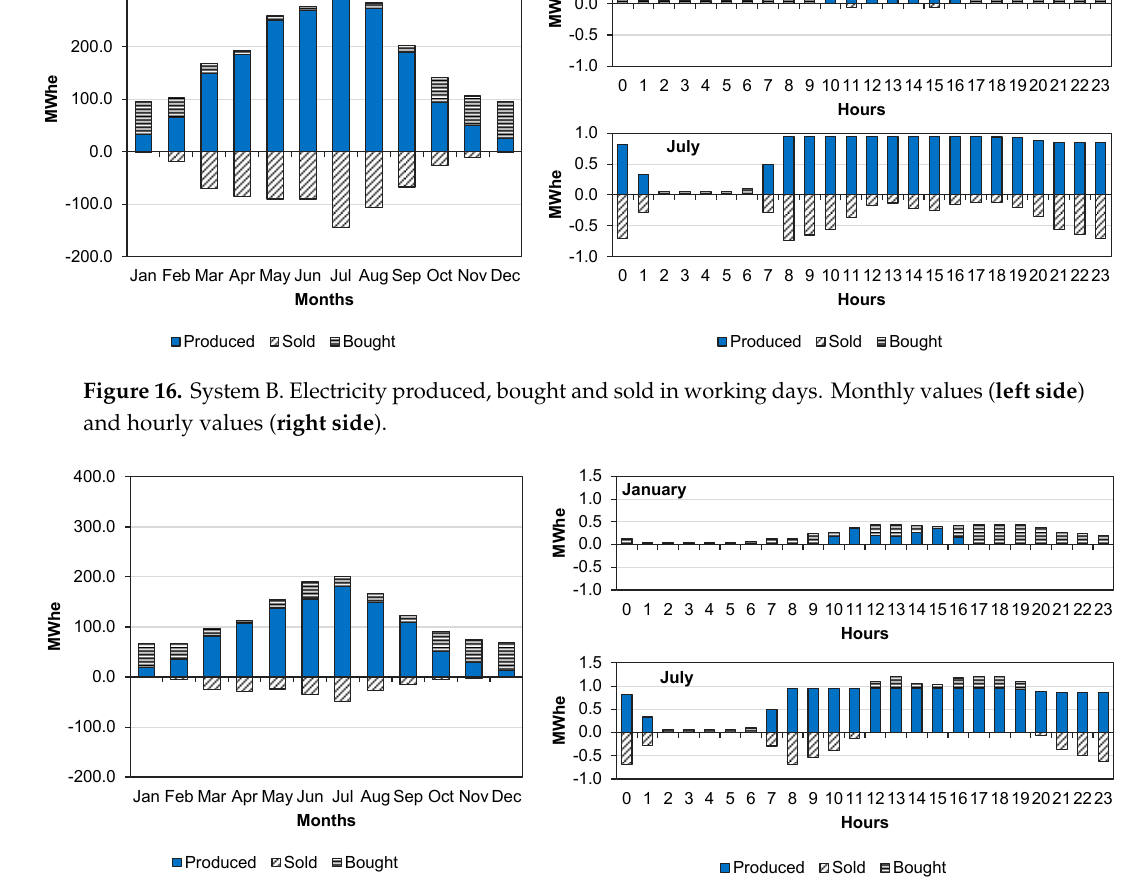
Figure 17. System B. Electricity produced, bought and sold in holidays. Monthly values (left side) and hourly values (right side).